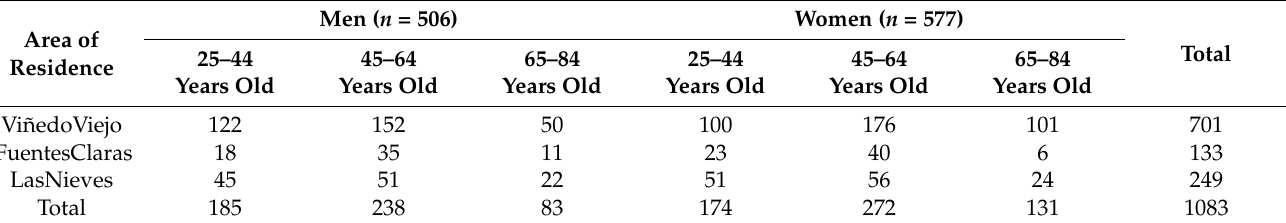
Table 1. Population and sample composition by gender, age group and area of residence.